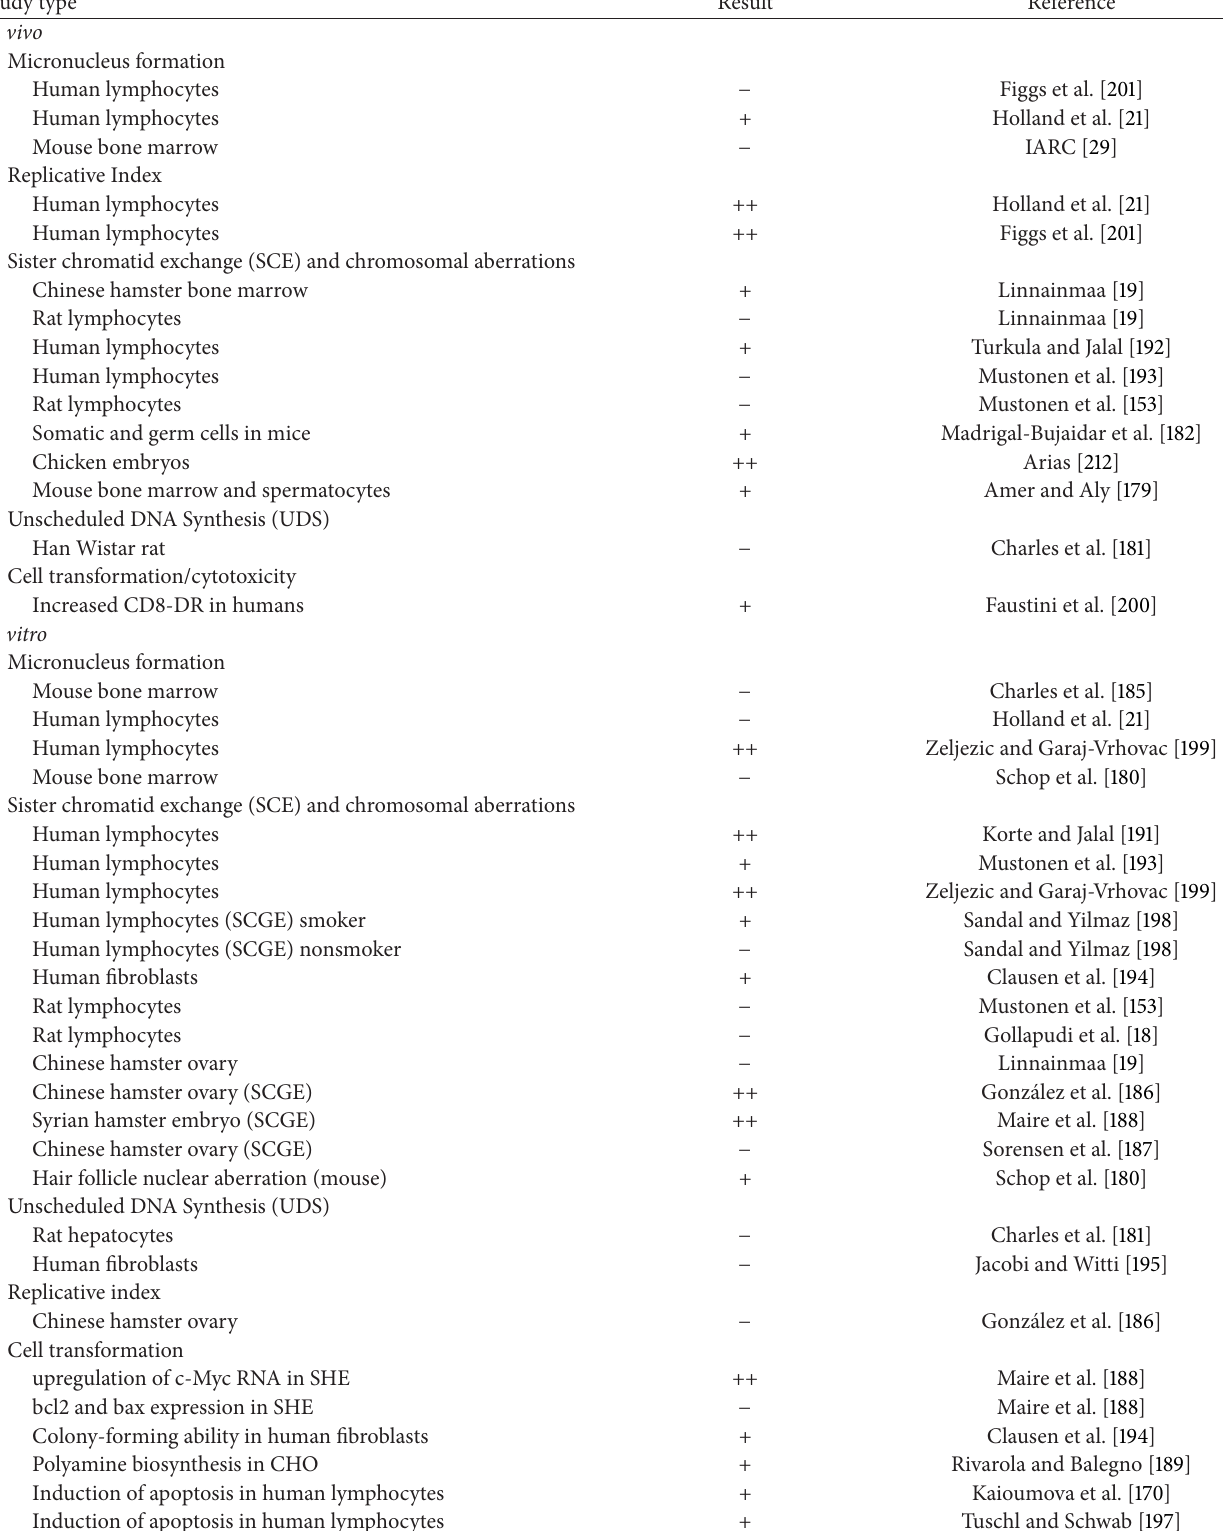
Table 9: Summary of evaluations of cellular interactions of